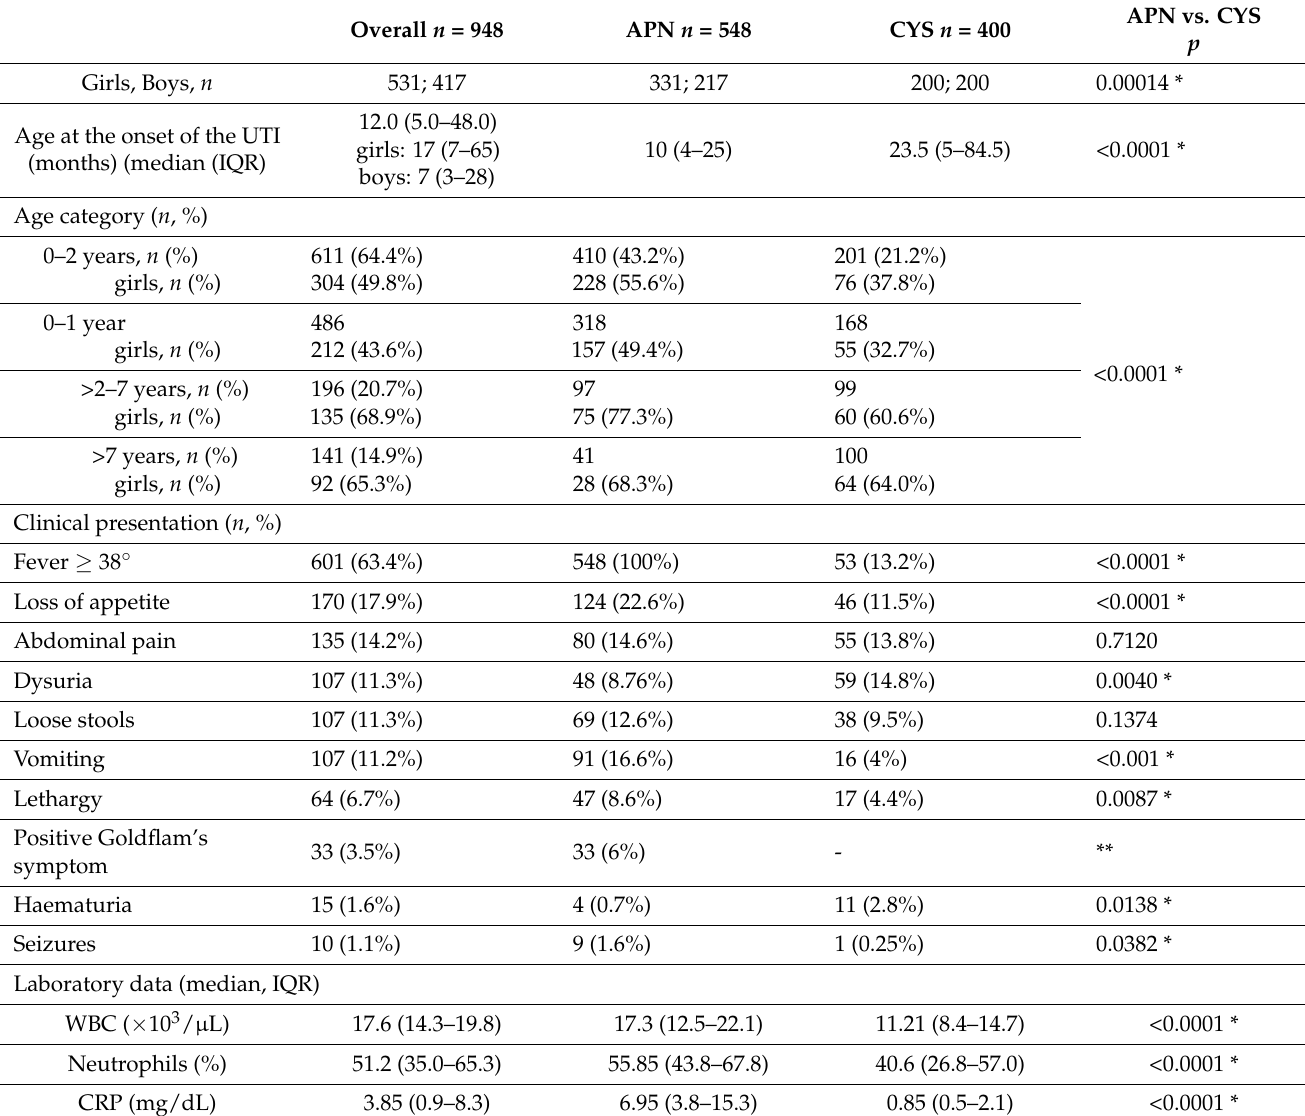
Table 1. Demographic data, clinical presentations, and laboratory data in children with UTIs.